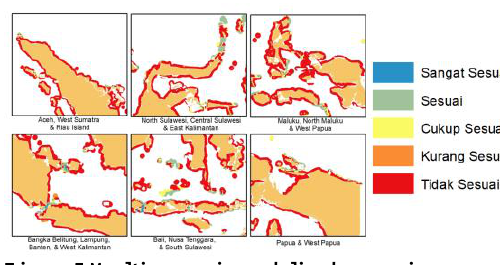
Figure 5 Multi-scenario modeling by province